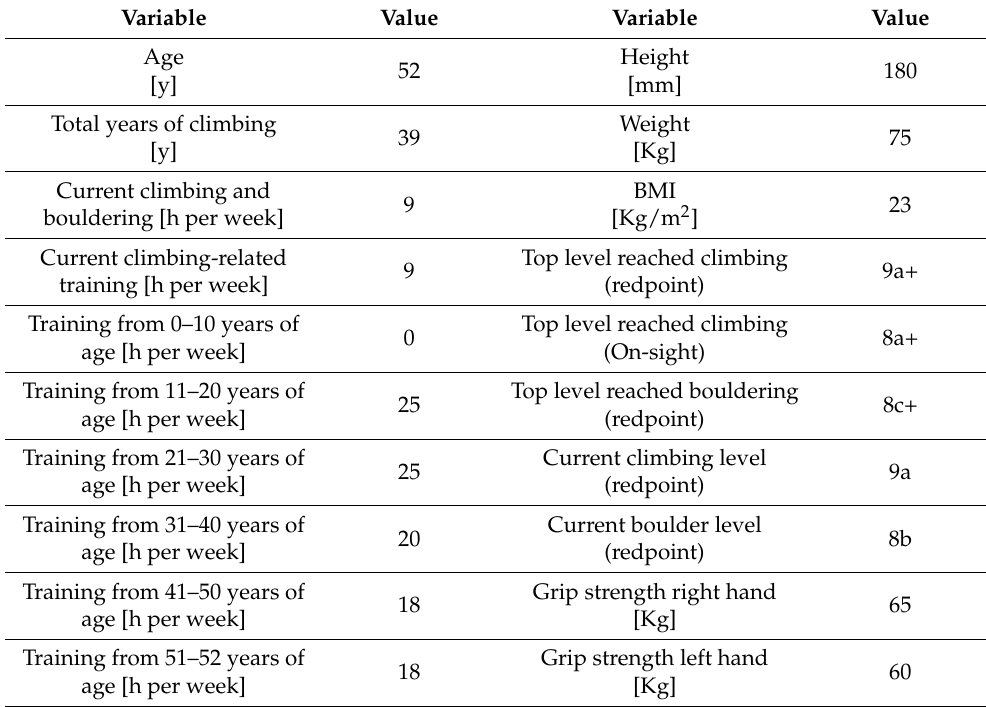
Table 1. Characteristics and anthropometrics of the investigated elite